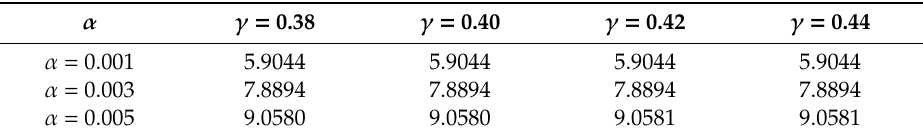
Table 3. The e ff ect of γ on the global shear buckling coe ffi cient k g , s when l / h = 5, h 2 / ( Rd ) = 5 and β = 1.8 α for the four-edge simple Table 3. The effect of γ on the global shear buckling coefficient k g , s when l/h = 5, h 2 /( Rd ) = 5 and β = 1.8 α for the four-edge simple support.